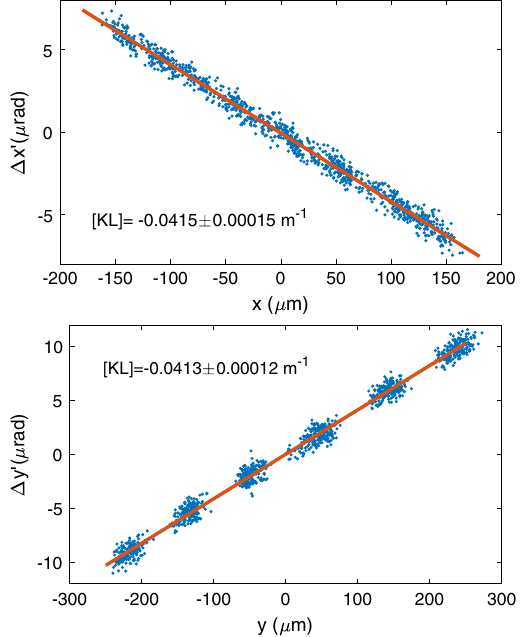
FIG. 8. Fitting kick angles to trajectory offset to derive integrated quadrupole gradient for quadrupole Q28601, using horizontal data (top), or vertical data (bottom). Each plane uses 1080 data